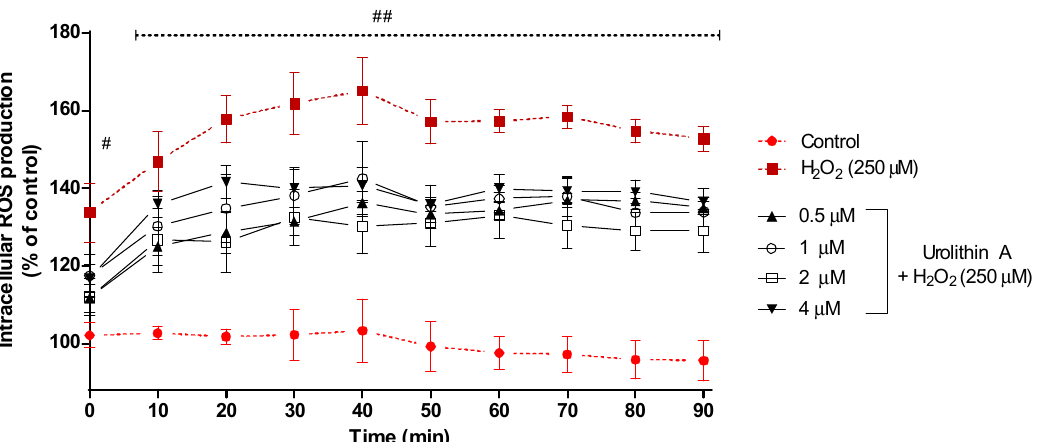
Figure 3. ROS production in Neuro-2a cells subjected to oxidative stress by hydrogen peroxide (250